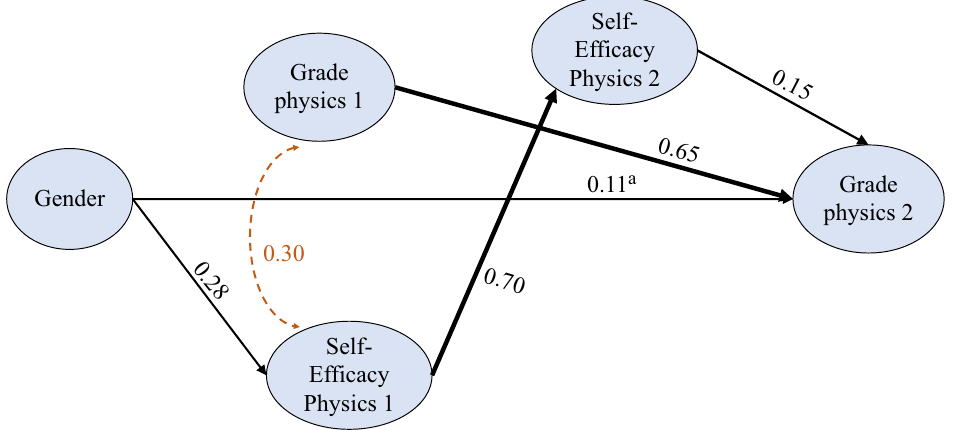
FIG. 5. Result of the path analysis part of the SEM without high school GPA and SAT math between gender and physics 2 grade through students ’ self-efficacy for model 4. The line thickness indicates the relative magnitude of β values. The dashed lines indicate covariances between constructs. p values are indicated by no superscript for p < 0 . 001 and superscript “ a ” for p ¼ 0 . 007 .